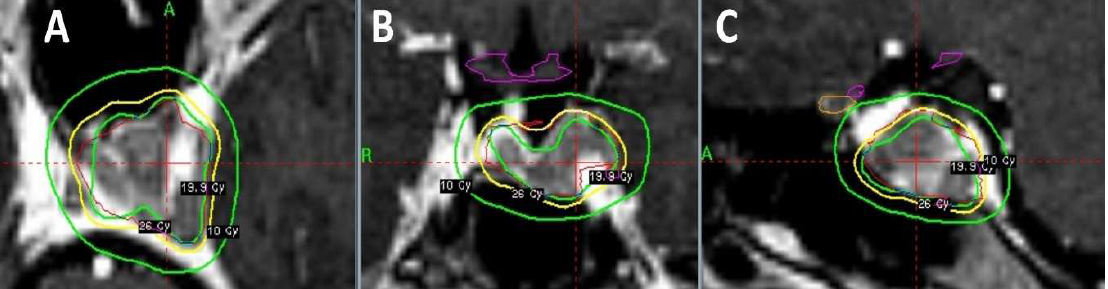
Figure 3. Stereotactic RT in the pediatric setting. This case is that of a 17-year-old female who presents with enlarging residual pituitary adenoma. The patient was initially treated one year prior with subtotal trans-nasal endoscopic resection of a non-secreting pituitary adenoma. On subsequent MRI surveillance, she was noted to have slow enlargement of residual pituitary adenoma. She was therefore recommended for salvage stereotactic RT to this residual disease. She was treated with a single-fraction of stereotactic radiosurgery, prescribing 19.9 Gy to the 50% isodose line. Shown here are representative ( A ) axial; ( B ) coronal; and ( C ) sagittal sections of the plan, with 10 Gy, 19.9 Gy, and 26 Gy isodose lines. Critical structures are appropriately avoided using this highly-conformal single-treatment technique, including optic chiasm (purple contour) and left optic nerve (orange contour).